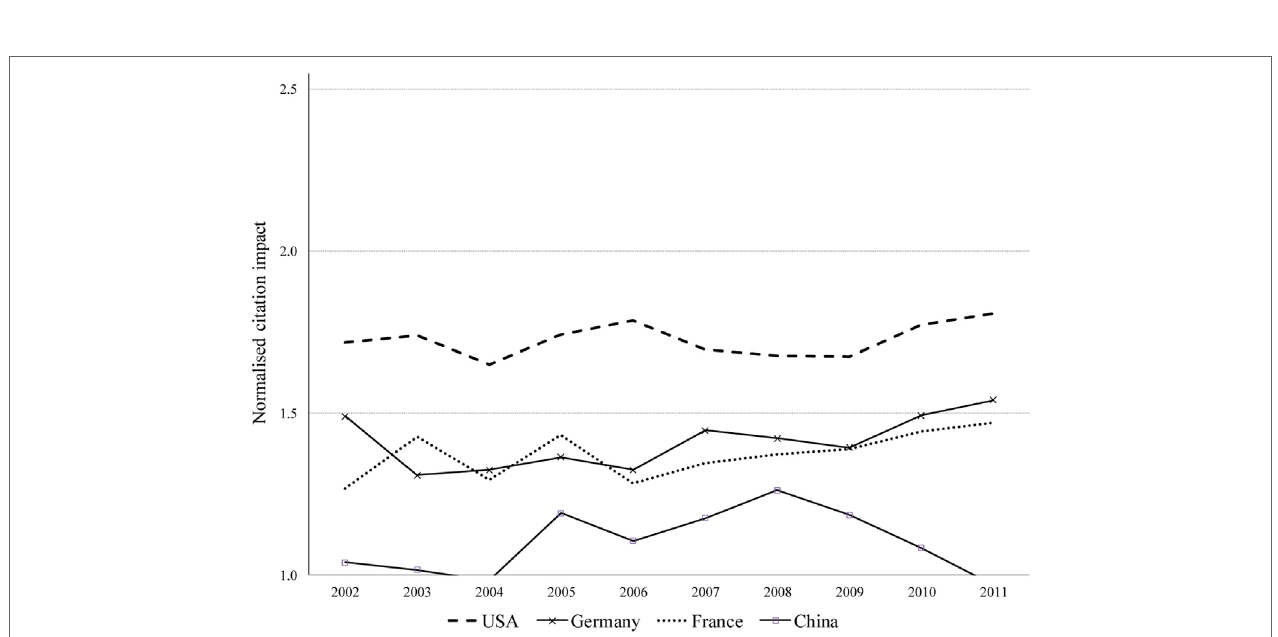
FigUre 5 | Normalized citation impact of UK papers co-authored with a partner country where the named partner is the only collaborator; the USA contributes the greatest benefit but the trend is flat whereas the benefit from EU partners is rising.